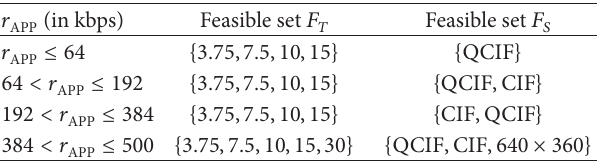
Table 1: Feasible sets considered for simulation of perceptual